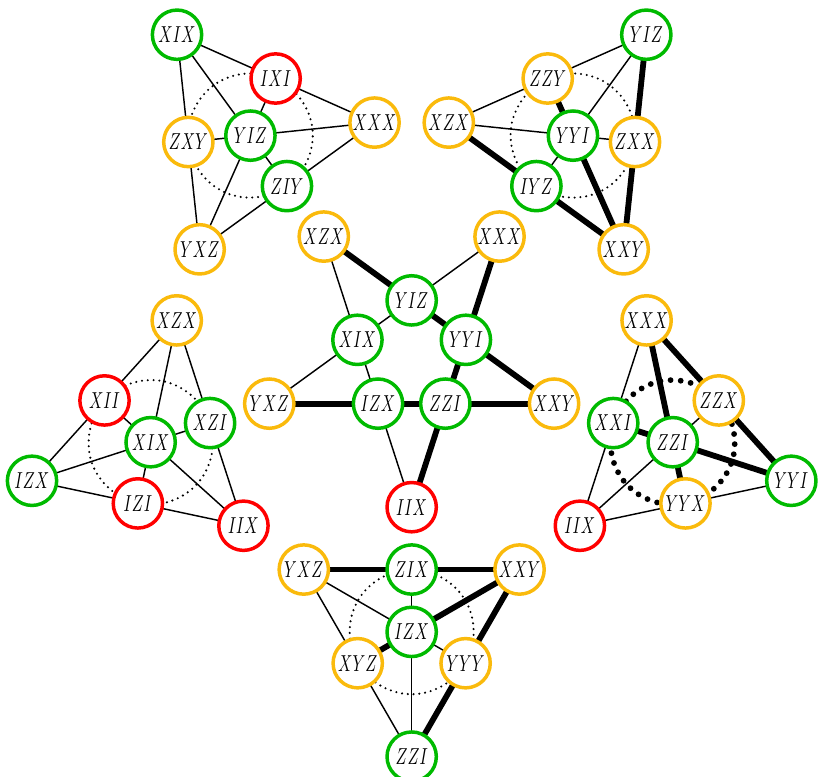
Figure 1. A Fano pentad and the corresponding Mermin pentagram. The Fano plane at the bottom corresponds to the horizontal edge of the pentagram; the remaining correspondences follow readily from the rotational symmetry of the figure. Following Ref. [8], the three different types of observables are distinguished by different coloring and negative contexts are represented by thick lines; also, G 1 ⊗ G 2 ⊗ G 3 is short-handed to G 1 G 2 G 3